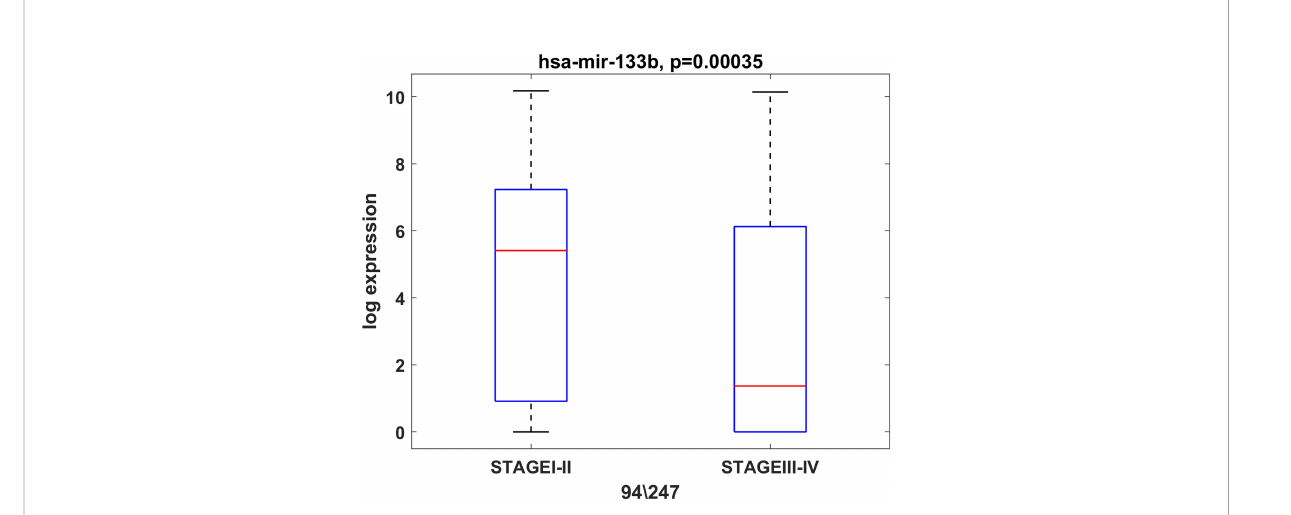
(Table 2). Each of the 14 genes negatively correlated to